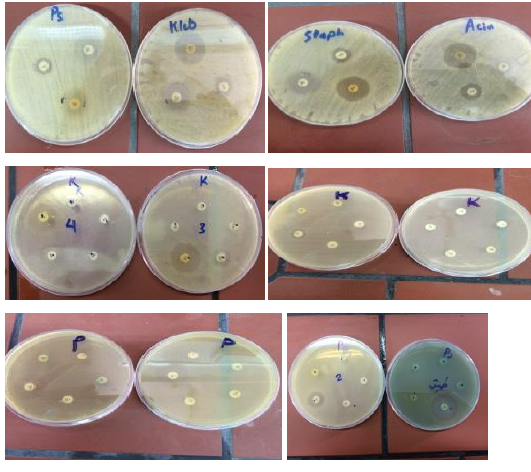
Figure (1) Antibiotic sensitivity test